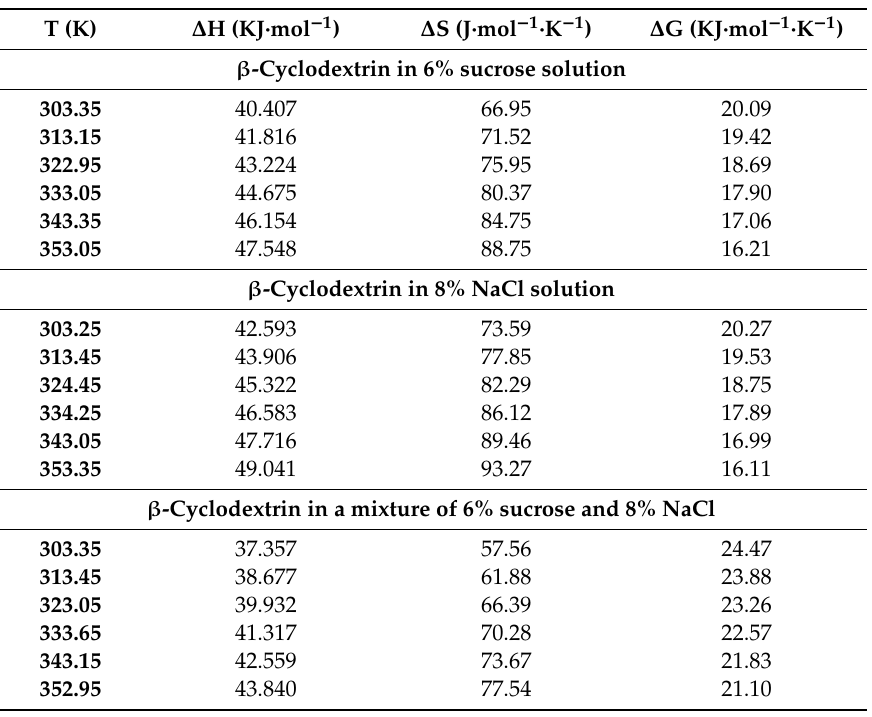
Table 9. ∆ H and ∆ S of β -Cyclodextrin in di ff erent solutions.